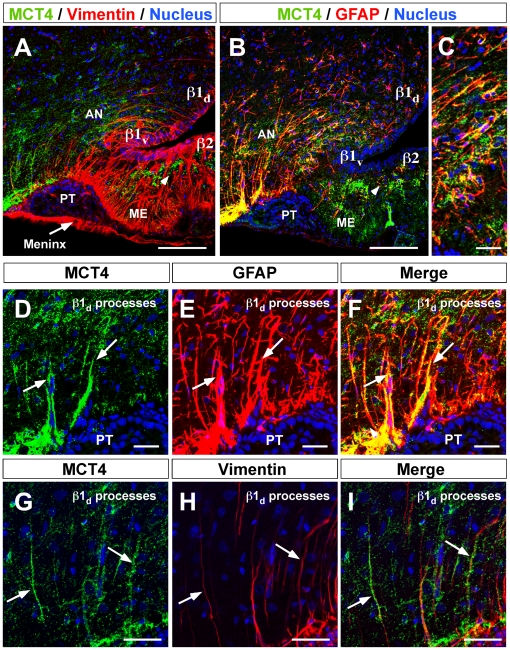
MCT4 localization in dorsal β1-tanycytes.
A, Low magnification of hypothalamic area using anti-MCT4 antibodies (green), anti-vimentin antibodies (red), and the nuclear stain, TOPRO (blue). B, Low magnification using anti-MCT4 antibodies (green), anti-GFAP antibodies (red), and the TOPRO nuclear stain (blue). C, High magnification showing GFAP-positive processes of β1d-tanycytes in contact with lateral AN neurons. β1d-tanycytes processes were positive for MCT4 and GFAP (D–F). MCT4 was expressed in a number of β1-tanycyte processes, which expressed vimentin (G–I, arrows). AN, arcuate nucleus, III-V: third ventricle, ME: median eminence. Scale bar: A–B, 150 µm; C–I, 50 µM; J–L, 25 µm.